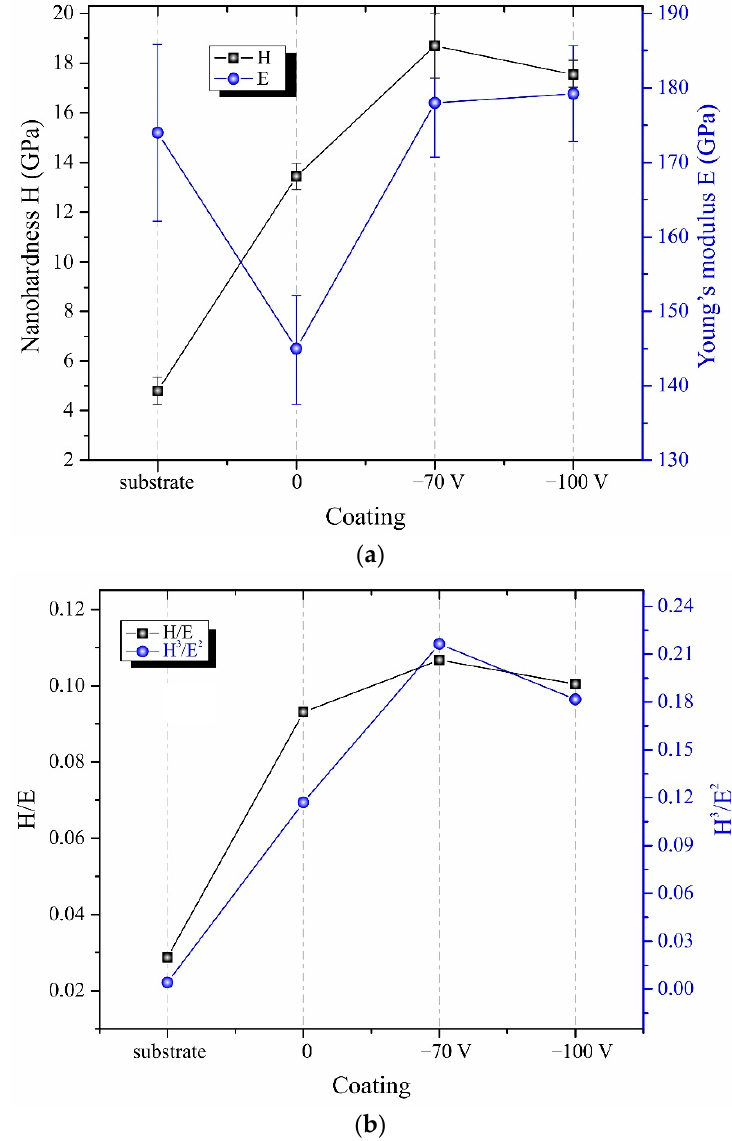
Figure 7. Nanohardness of VT6 substrate and TiCN coatings obtained at U s = 0, − 70, and − 100 V: ( a ) nanohardness and Young’s modulus; ( b ) H/E and H 3 /E 2 values for substrate and obtaining coatings.